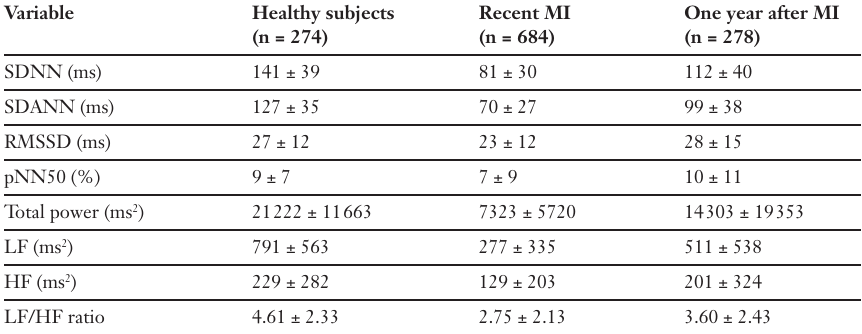
Reference values for measurement of time domain and spectral parameters in healthy middle-aged subjects and in patients after myo- cardial